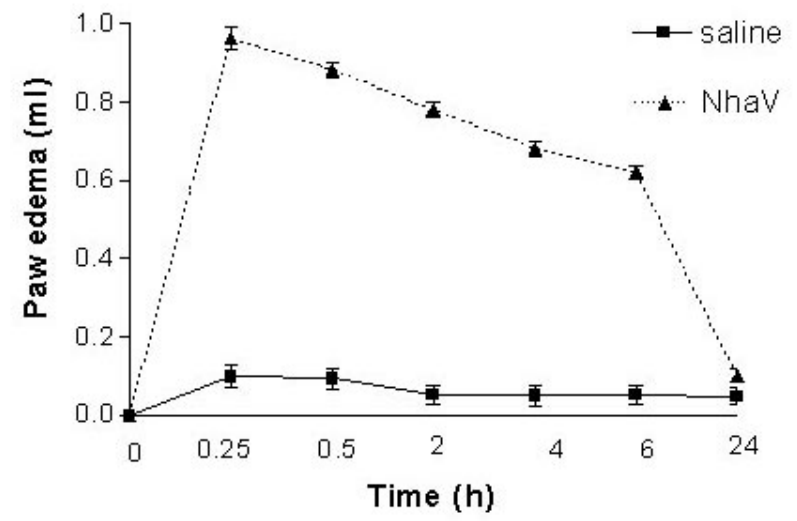
Figure 1B: Time-course of the rat paw edema induced by NhaV (15min to 24h) using 5µg/paw of venom ( ▲ ), compared to saline ( ■ ). The control group received saline (0.1ml) in the same experimental